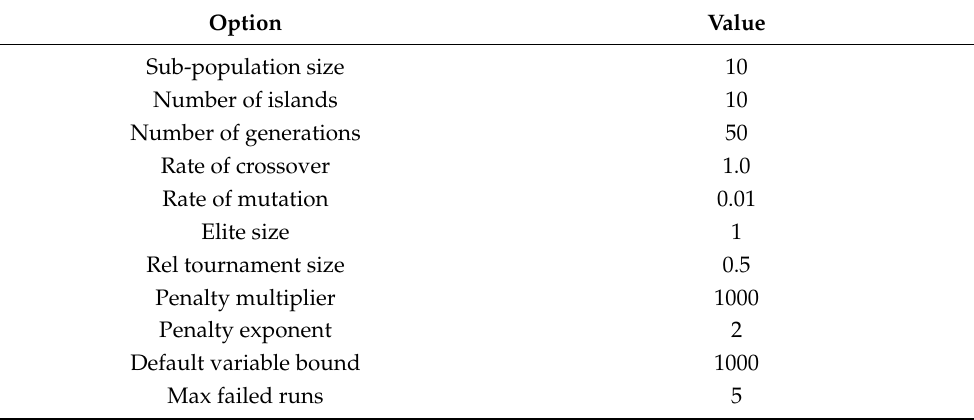
Table 5. The parameter settings of the optimization algorithm. Option